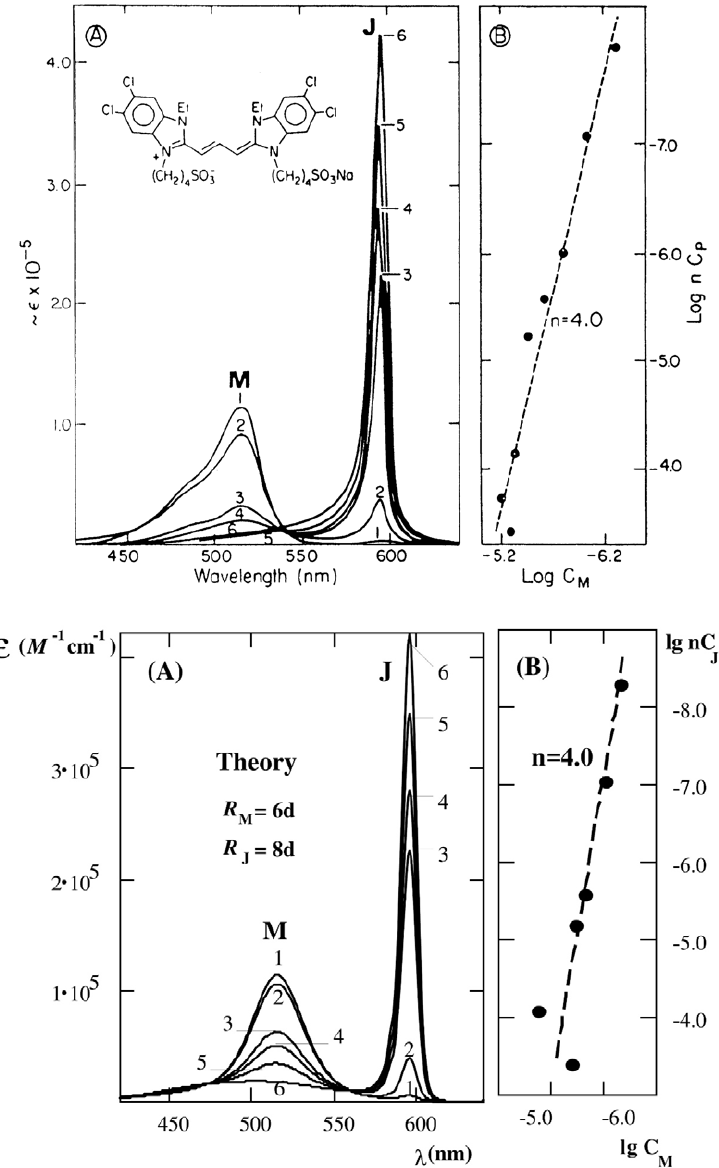
Figure 6. At the ( top ): Hertz experimental data on the optical absorption of monomers (M) and J-aggregates (J) of benzimidazolocarbocyanine, which are in concentration equilibrium in an aqueous NaOH solution (0.001 mol L − 1 ) at 25 ◦ C [36,74]. ( A ) Dye concentration is measured in micromole/liter: 0.5 ( 1 ), 1.0 ( 2 ), 5.0 ( 3 ), 10 ( 4 ), 100 ( 5 ), and 400 ( 6 ). ( B ) Molar concentrations of the dye monomers ( C M ) and J-aggregates ( C J ) are taken from ( A ). The number of molecules N in the J-chromophore (Figure 5) is calculated from the law of mass action and is equal to 4. At the ( bottom ): Theoretical band shapes fitted to Hertz’s experimental data (see at the ( top )) [22–24]. ( A ) Absorption M-bands and J-bands are calculated from Equations (7)–(28) with η = 1. The relative dye concentrations in the intermediate states are: 1% ( 1 ), 9% ( 2 ), 53% ( 3 ), 66% ( 4 ), 82% ( 5 ), and 99% ( 6 ). ( B ) Molar concentrations of the dye monomers ( C M ) and J-aggregates ( C J ) are derived from the absolute concentrations reported by